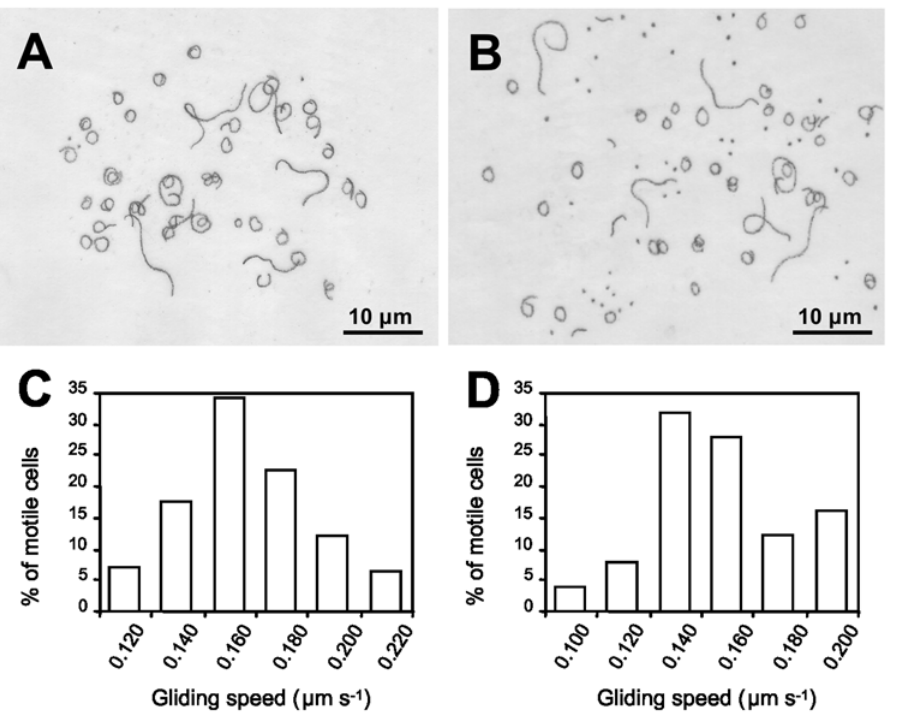
Figure 4. Gliding motility analysis. Tracks described by cells from the WT strain (A) and the T192 mutant (B) in two minutes. Distribution of the gliding velocities in the WT strain (C) and the T192 mutant (D). Note the presence of a large number of non-motile cells (scattered dots) in the population of the T192 mutant.